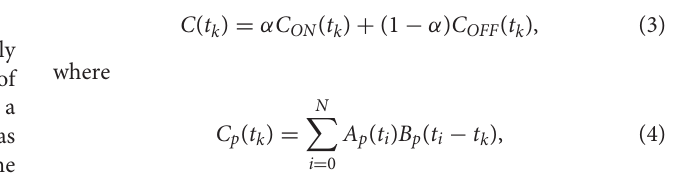
overall input focal plane is divided into one grid of n × n tiles, overlapped with a second similar grid made of ( n − 1) × ( n −